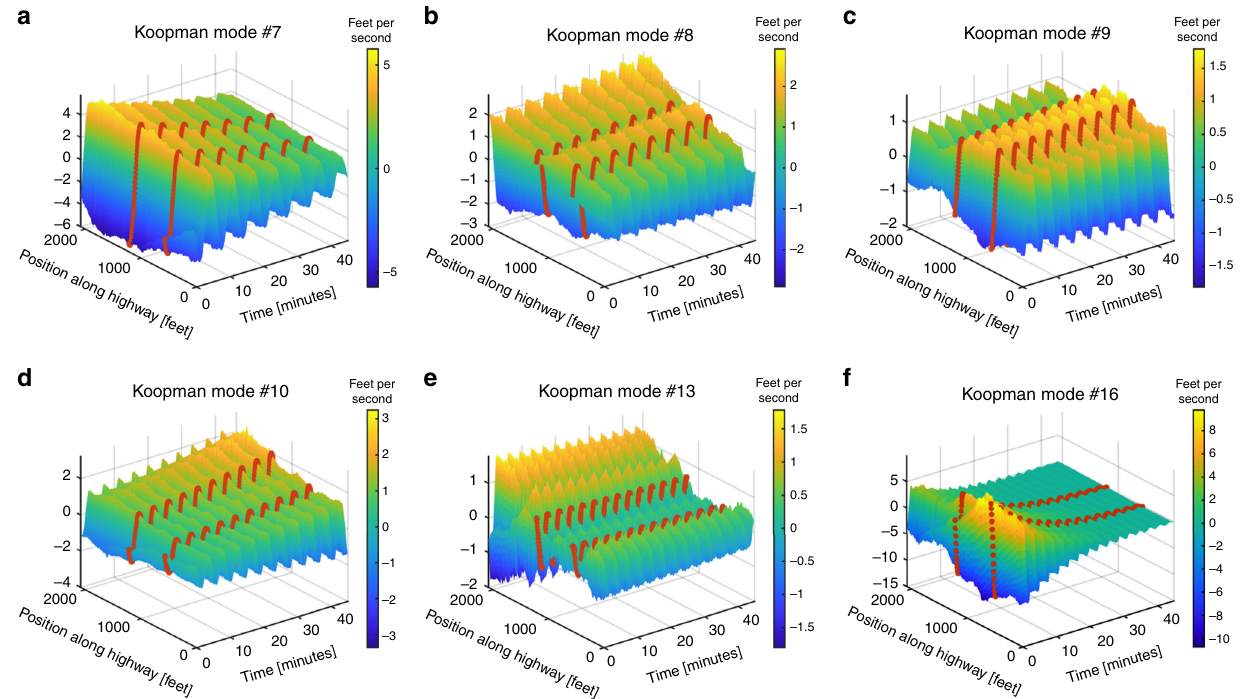
Fig. 3 Koopman modes demonstrating the ability to uncover growing or decaying patterns. The on/off-ramp locations have been labeled with dark orange dotted lines. Mode 7 propagates across the entire highway without disturbances to its amplitude and thus corresponds to a highway wide traf fi c jam also known as a moving localized cluster (MLC). Mode 9 provides further evidence for the pumping effect, where an apparent increase in amplitude followed by a decrease can be seen as the mode propagates past the off and on-ramps respectively. However, mode 8 seems to display a decrease in amplitude followed by another decrease when propagating past the off and on-ramp respectively. This phenomenon to the author ’ s knowledge has not been reported by other empirical studies. Modes 10 and 16 demonstrate our method ’ s ability to uncover growing or decaying patterns. Speci fi cally, mode 16 appears to contain its amplitude almost entirely during the fi rst 10 – 15 minutes and concentrated in the pre-on-ramp location of the highway. This indicates that mode 16 corresponds to the stop and go waves (SGW) present during the exact same region of the spatiotemporal data in Fig. 1a. The exact growth or decay rate of the mode is dictated by the real part of its corresponding eigenvalue. This again is a distinguishing feature of our methodology from a Fourier analysis in that Fourier modes do not capture growing or decaying features. Lastly, mode 13 also demonstrates a double-peaked structure resembling a spatial harmonic feature of Fig. 2a – c. A complete list containing the periods of oscillation of the modes we discussed can be referenced in